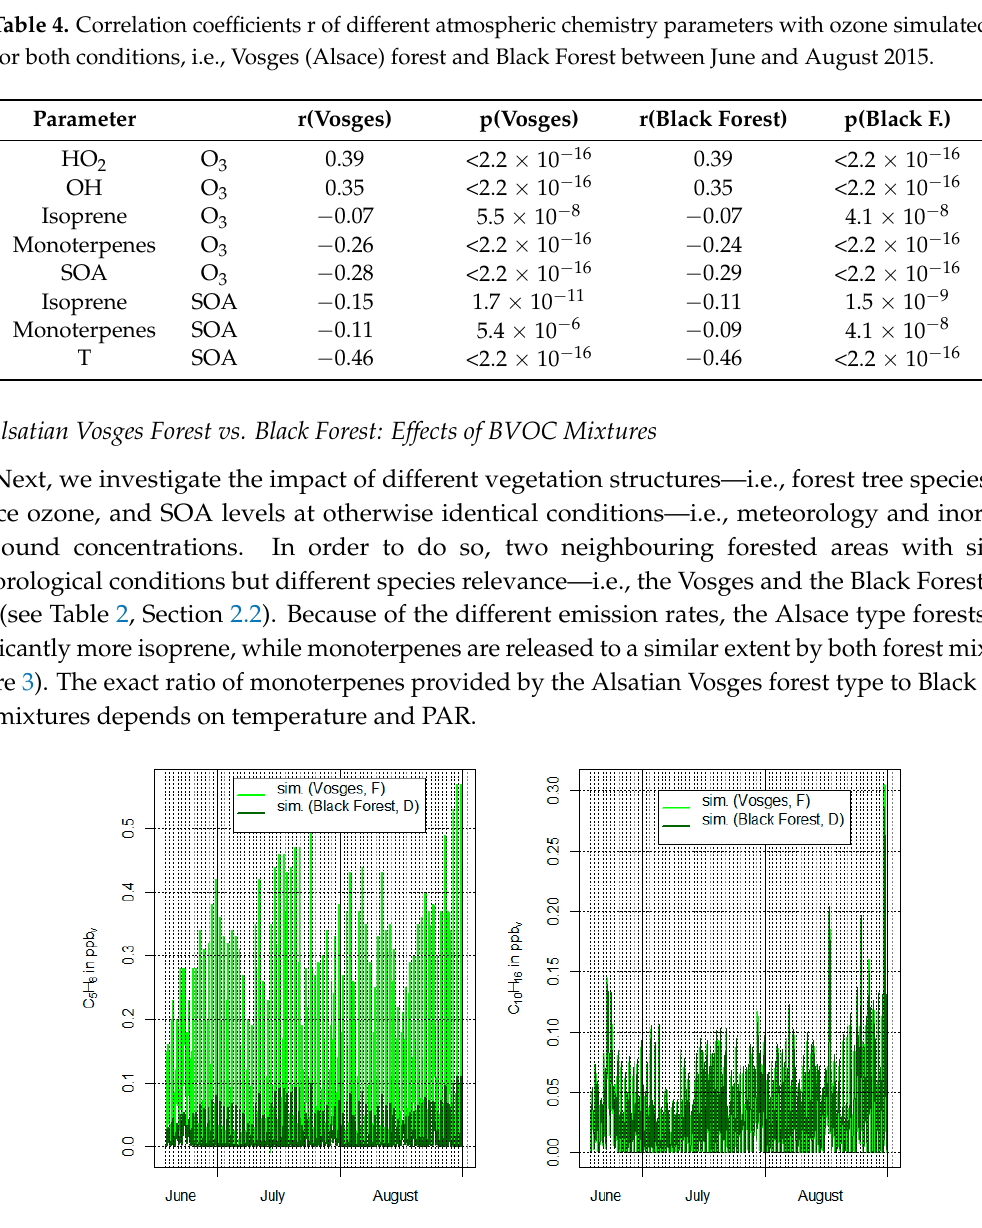
Figure 3. Estimated average summertime isoprene ( left ) and monoterpene ( right ) mixing ratios above the Vosges forest type and Black Forest type forest. Light green represents Vosges forest type conditions and dark green Black Forest type ones.